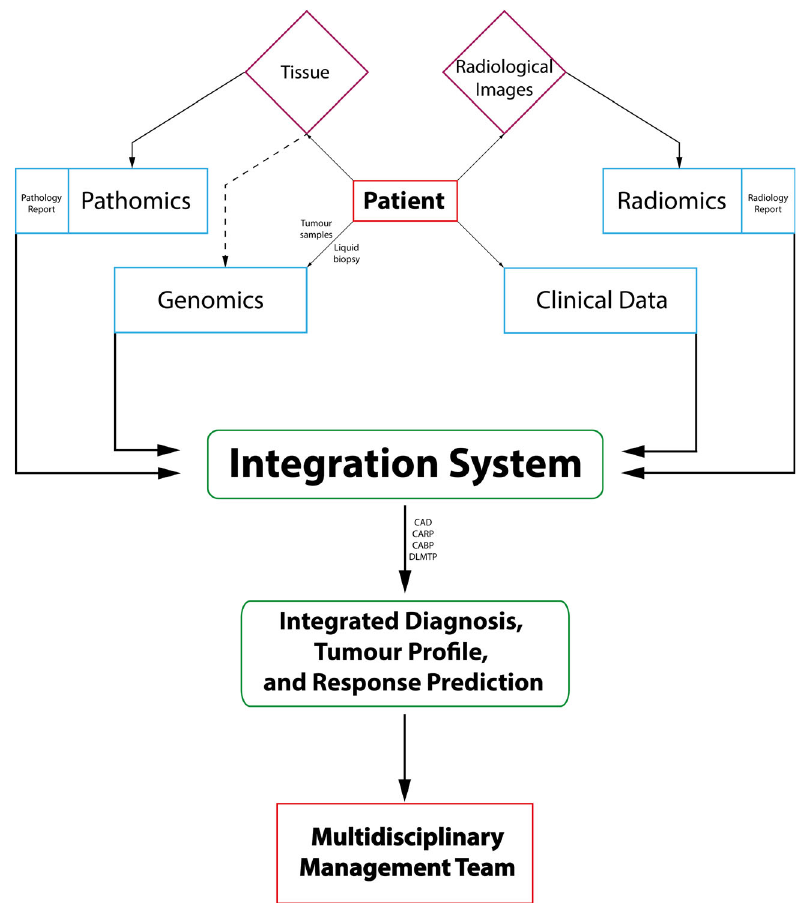
Fig. 2 A schematic flow chart envisioning the usage of patient- derived data (in light blue) from raw materials (in purple) as a means to improve CAD, CARP, and CABP and ultimately help guide decisions by the